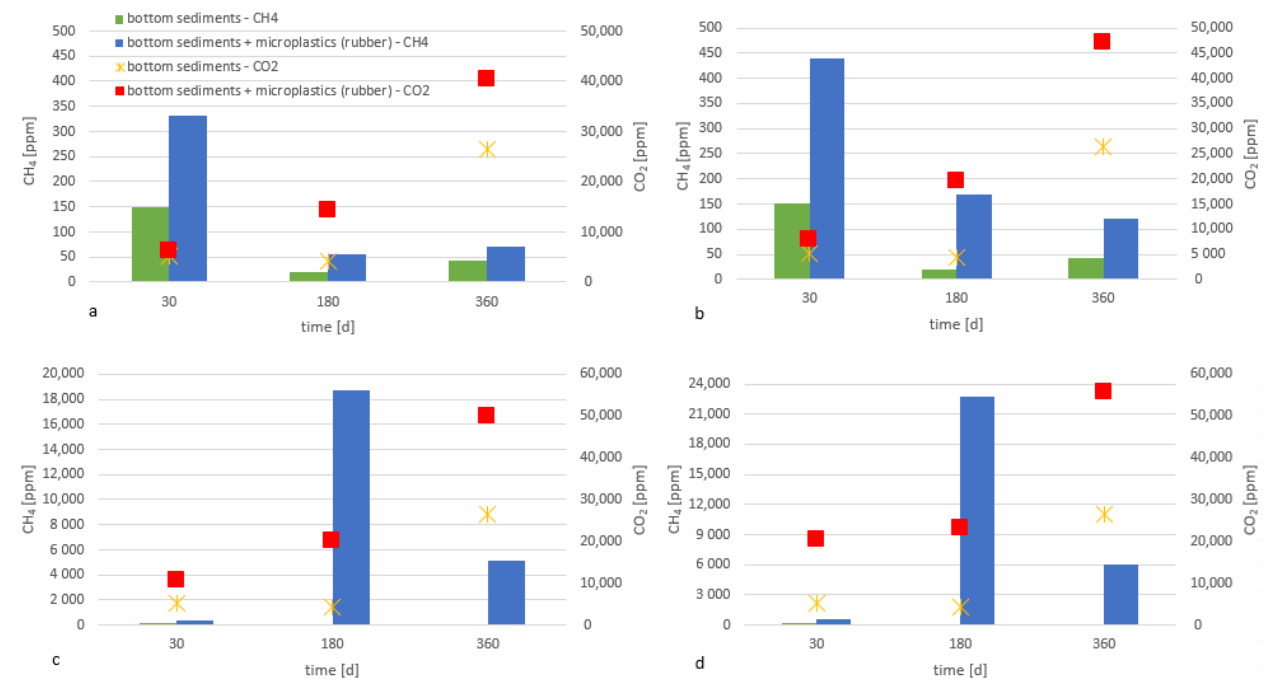
Figure 5. CH 4 and CO 2 emissions from rubber at sizes ( a ) 3000 – 8000 µm; ( b ) 1000 – 3000 µm; ( c ) 1000 µm; ( d ) 600 µm.